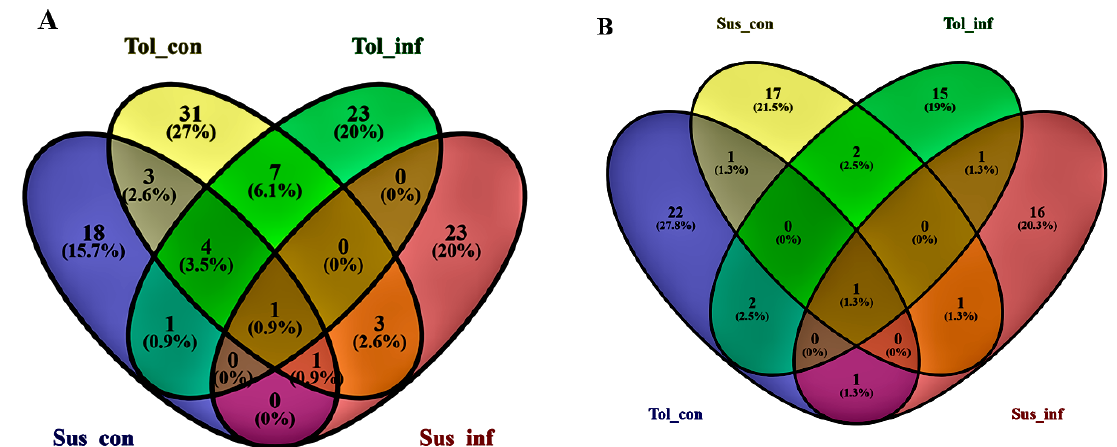
Figure 6. Venn diagrams displaying partial overlap of statistically significant biomarkers selected from the four OPLS-DA models comparing extracts from the ( A ) roots and ( B ) root exudates of four sample groups: Tol-con (tolerant uninoculated), Sus-con (susceptible uninoculated), Tol-inf (tolerant inoculated), and Sus-inf (susceptible inoculated). The numerical values in the diagrams depict the number of metabolites that are unique to certain cultivar groups or shared between the cultivar